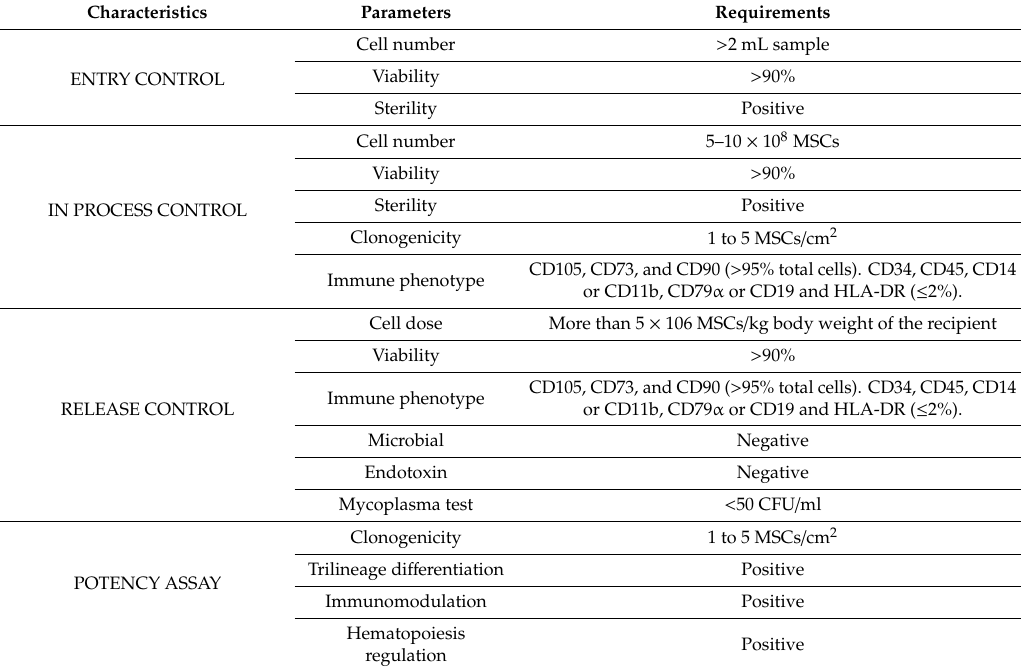
Table 3. The released parameters for mesenchymal stem cells (MSCs)